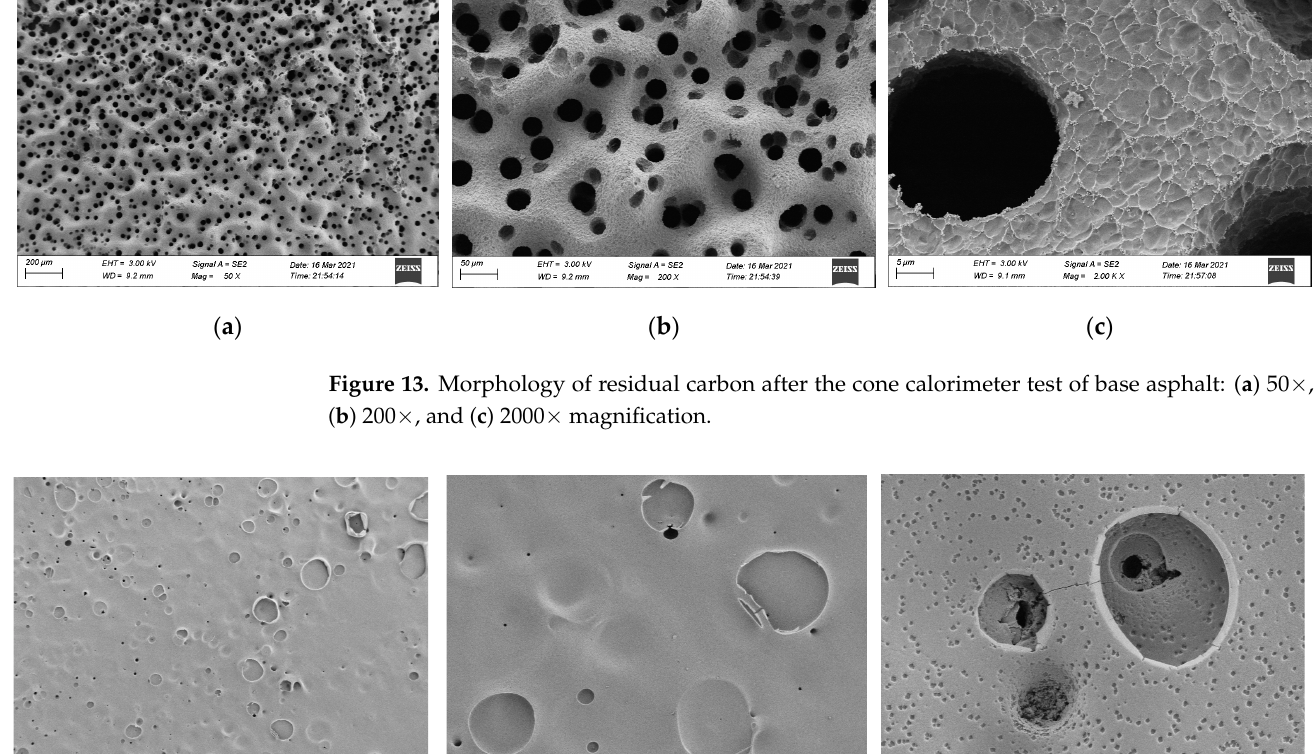
( c ) Figure 15. Morphology of carbon residue after the cone calorimeter test of epoxy asphalt: ( a ) 50×, ( b ) 200×, and ( c ) 2000× magnification. At high temperature, the surface of base asphalt will flow and agglomerate, result- ing in molten droplets, which accelerates the endothermic decomposition of asphalt. Af- ter combustion, the surface of residual carbon presented a uniform high-low fluctuation shape, which is a skeleton pore structure and has many through holes with a large pore diameter and loose structure. This is mainly caused by the precipitation of internal de- composition gas breaking through the barrier layer during asphalt combustion. Notably, more through holes indicate more volatile matter in gas phase. Under a high-power mi- croscope (2000× magnification), it can be observed that the residue had a fine-scale structure, which may be formed by stacking collapsed structures after decomposition. The carbon residue rate of epoxy resin after combustion was low, but the carbon residue surface was dense and flat with few through holes. The main reason for this is that the volatile content was relatively small, and the Figure 14c 2000× magnification figure shows that the combustion form is deepening combustion layer-by-layer at the hole-forming place. It can be seen from Figure 15 that after the combustion of epoxy asphalt, the surface of residual carbon presented uneven high and low fluctuation, and the whole sample was an irregular network structure. The structure was rough and loose and had some holes with a large pore diameter; however, most of them existed in embedded nonpenetrating form, which is mainly caused by noncombustible gases such as N 2 and CO 2 released by polymers after combustion on the carbon layer. 4. Conclusions In this study, the pyrolysis and combustion characteristics of epoxy asphalt were examined using TG-MS, cone calorimeter, and SEM. The main conclusions are as follows: